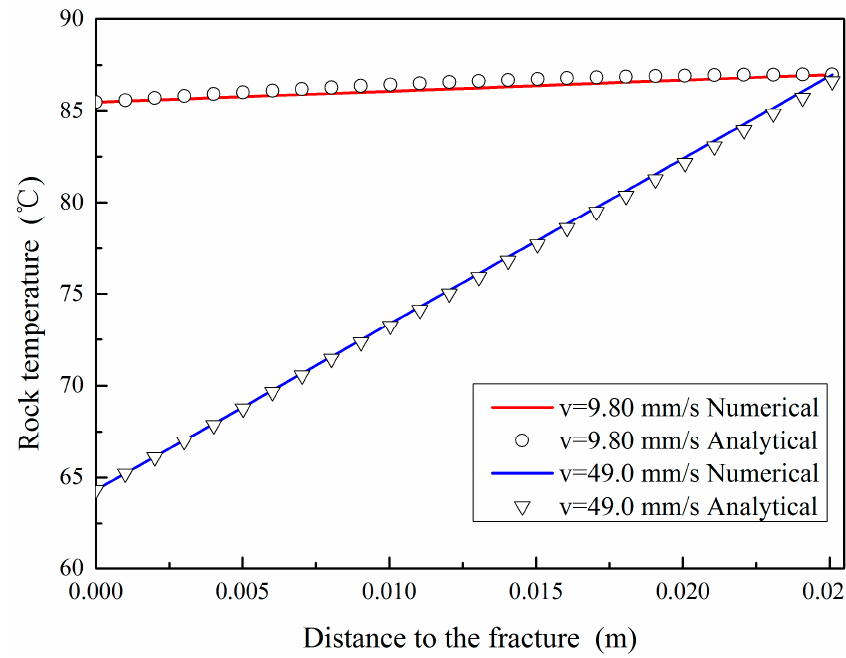
Figure 3. Rock matrix temperature along line AB.